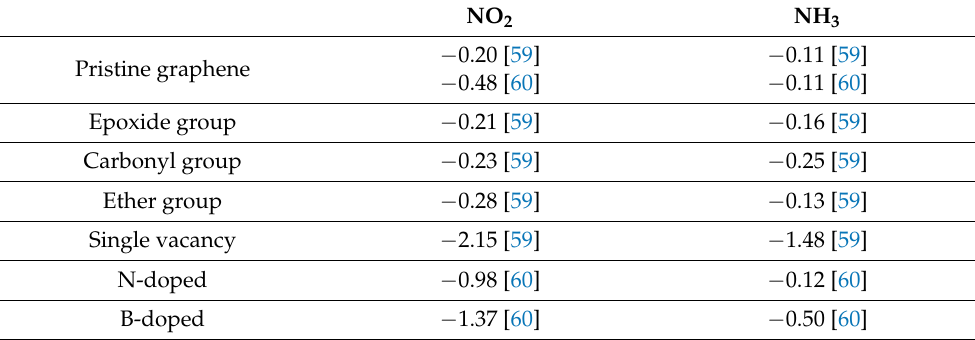
Table 1. Adsorption energy (in eV) for NO 2 and NH 3 on pristine graphene in the presence of different kinds of sp3 defects, at single vacancies and at N and B-doped sites. Data were taken from Ref. [59] and from [60]. NO 2 NH